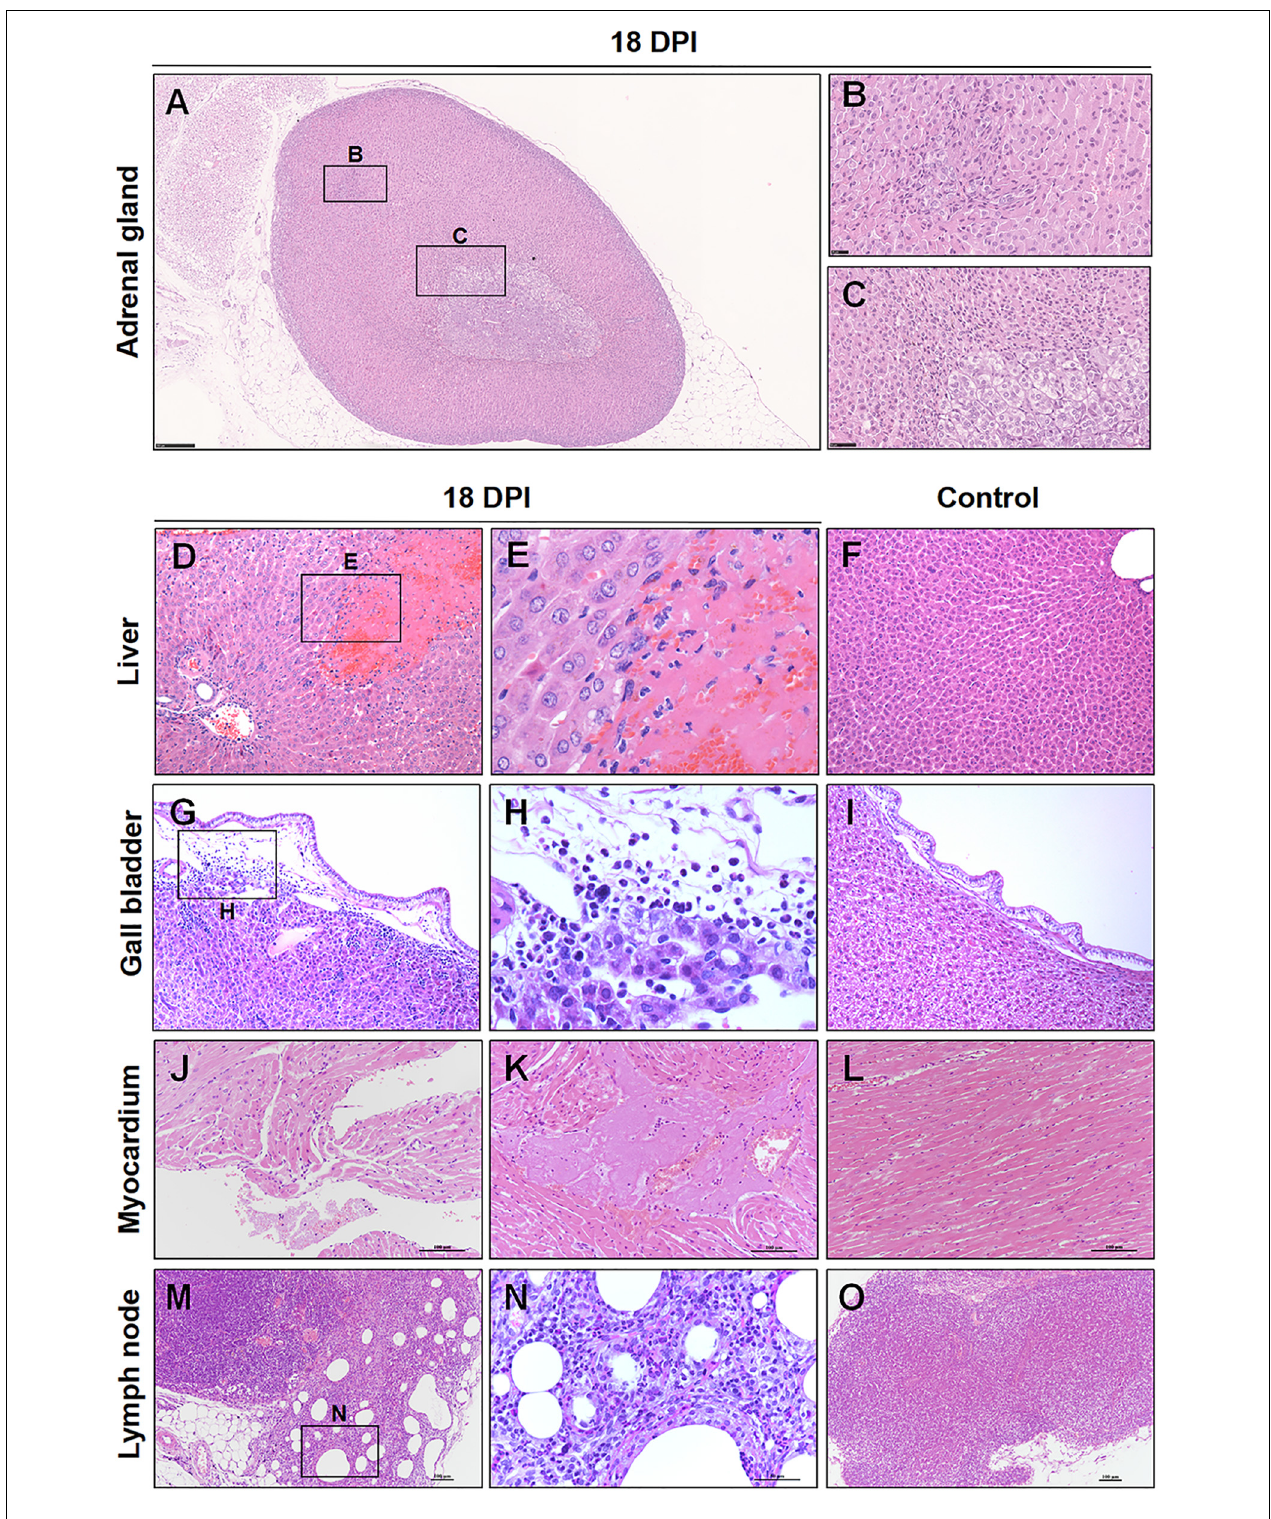
FIGURE 8 | Observation and examination of infected hamsters at 18 dpi. (A–C) Regeneration was present in the adrenal glands at 18 dpi. (D–F) Compared with the normal control liver, there was focal hepatocellular necrosis in the liver. (G–I) Compared with the normal control gallbladder, there were inflammatory cells in the submucosa of the gallbladder. (J–L) Compared with the normal control myocardium, the heart showed mild focal myocardial degeneration and inflammation. (M–O) Compared with the normal control lymph node, chronic lymphadenitis accompanied by fibrosis was present in one hamster at 18 dpi.